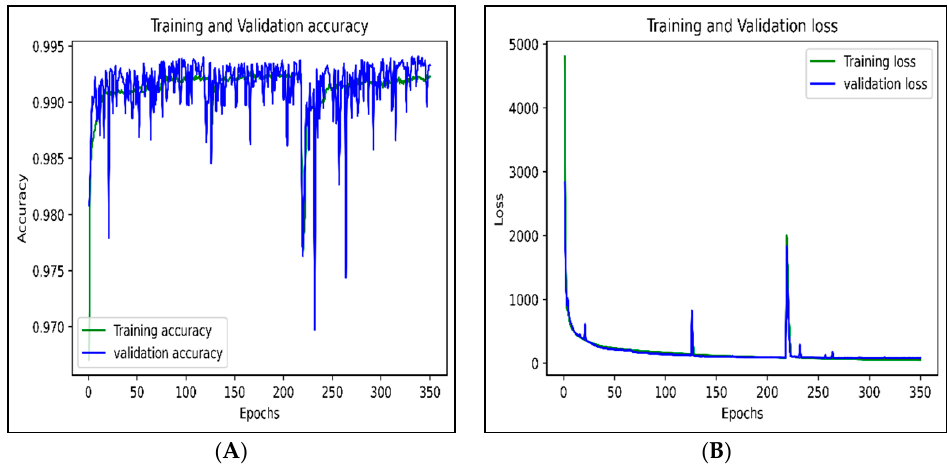
Figure 16. ( A,B ): Accuracy and Loss curves for Wednesday sub-dataset.